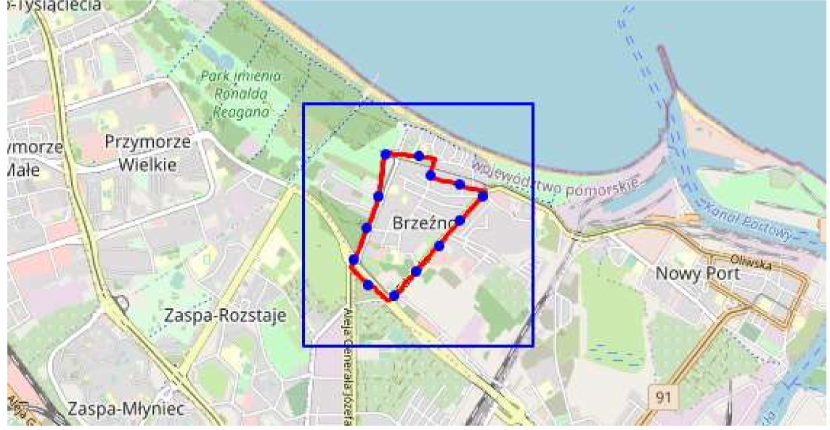
Figure 3. The software map area. The blue rectangle is the extent of the loaded DSM. The red line is an inspected route. The blue dots are sampling points where DOP values were